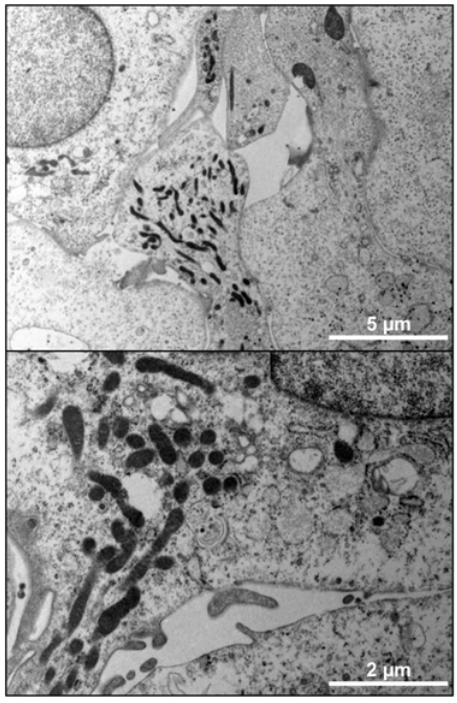
Figure 3. TEM of L929 cells infected with R. raoultii . (A) TEM performed on R. raoultii cultured for 48 h in L929 cells confirmed that bacteria multiply without infecting neighboring cells. (B) A higher magnification showed free bacteria in the cytoplasm and failed to demonstrate the presence of a membrane vacuole surrounding